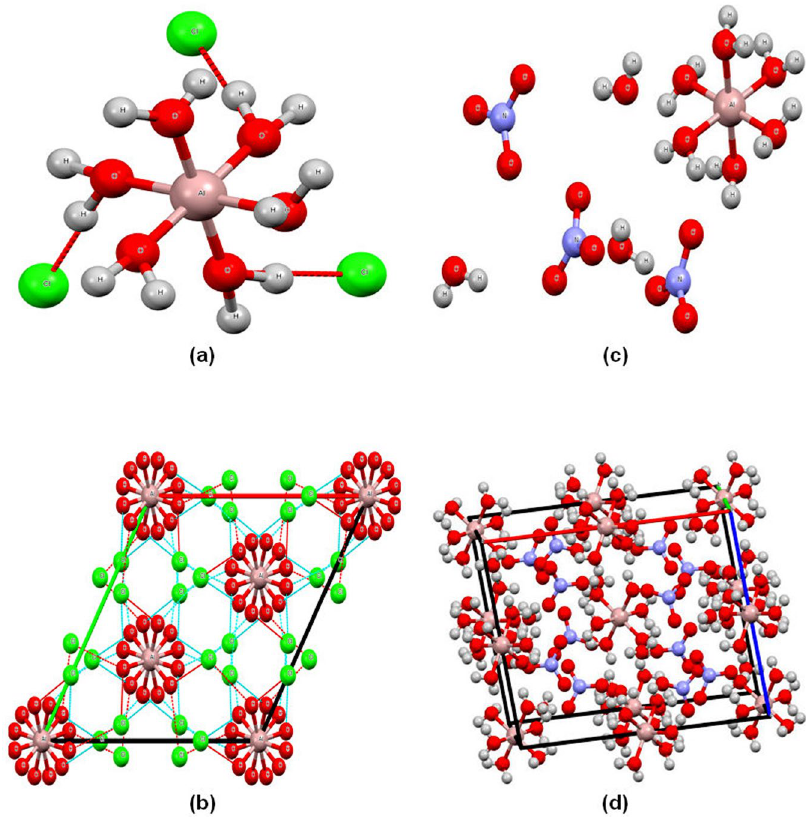
Figure 1. X-ray single crystal of homemade aluminium chloride hexahydrate in ( a and b ) and aluminium nitrate nonahydrate in ( c and d )derived from aluminum foil waste, where images ( b and d ) depict the packing cubic crystal structure viewed along [001].